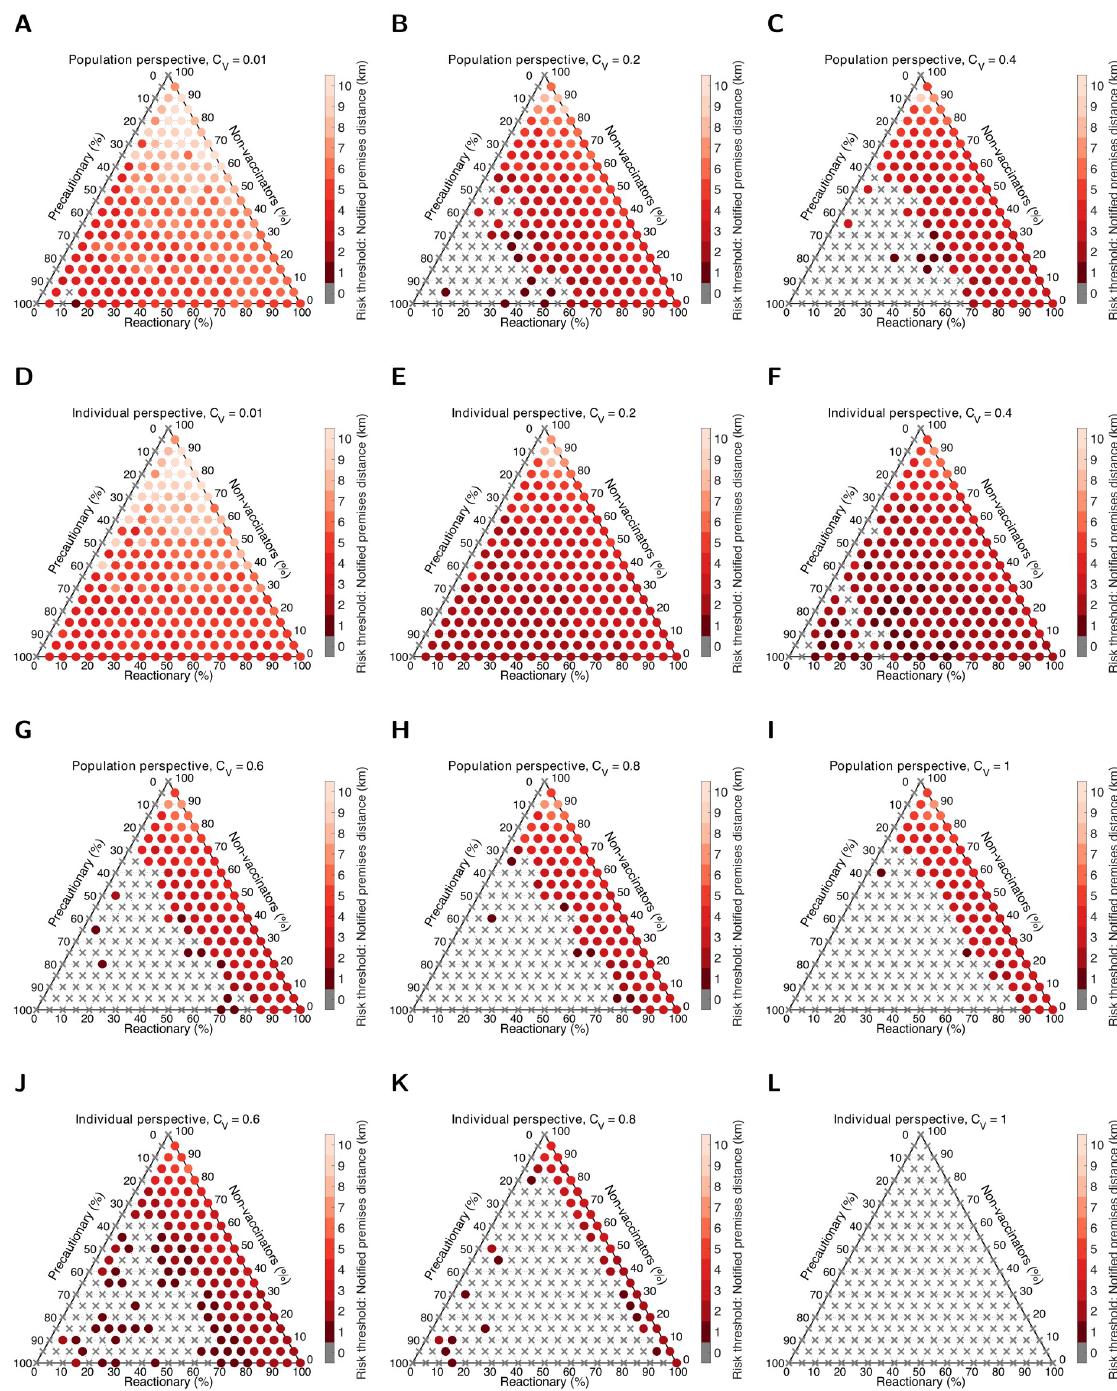
Fig 4. Strategy that minimises overall cost in Devon, dependent on the perspective, relative cost of vaccination and vaccine group composition. We performed 500 replicates per scenario. Shading corresponds to the notification distance risk threshold d that returned the lowest median cost across the control scenarios (dark to light corresponding to increases in distance from 1km to 10km). Grey crosses correspond to no reactive vaccination occurring. The ternary plots display optimal strategies from the population and individual perspectives given a relative cost of vaccination, C V , of: A,D 0.01; B,E 0.2; C,F 0.4; G,J 0.6; H,K 0.8; I,L 1. For an explanation on reading values on a ternary plot, see Fig B in the S1 Text.